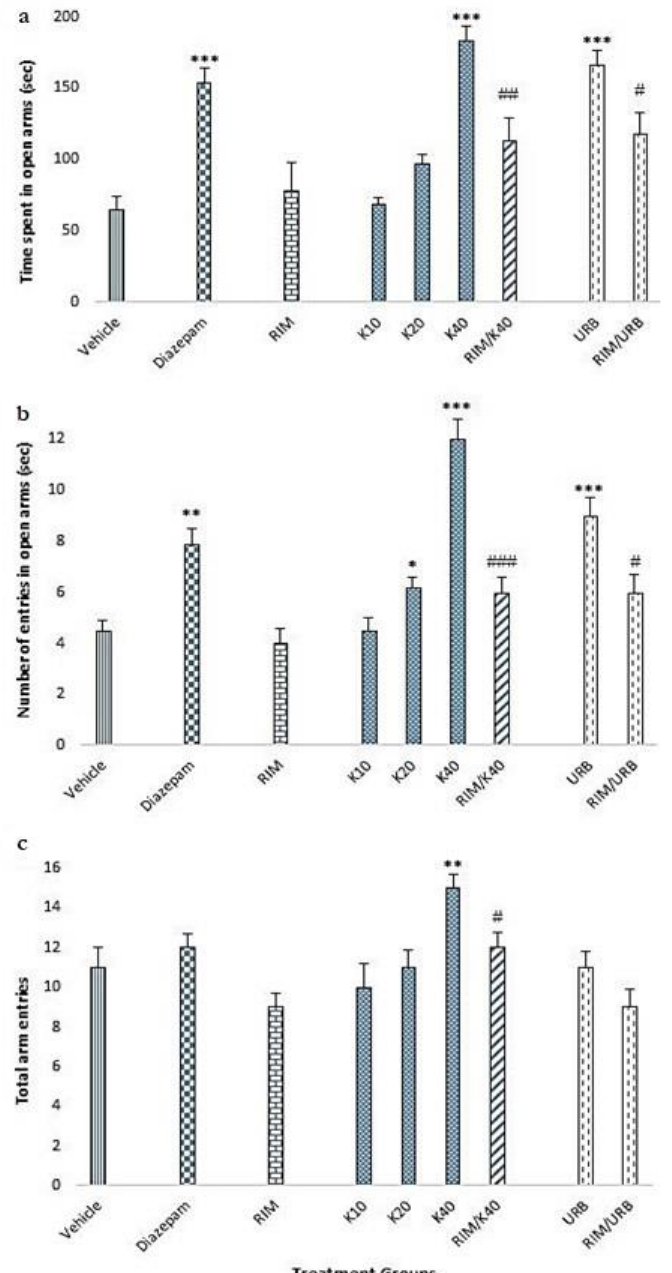
Figure 3. Effect of kaempferol on the levels of anxiety in elevated plus maze. After CFC, rats were subjected to EPM and parameters were noted: ( a ) Time spent in open arms. ( b ) Number of entries in the open arms. ( c ) Total arm eateries. Diazepam was used as standard. * p < 0.05, ** p < 0.01, and *** p < 0.001 as compared to vehicle control. # p < 0.05, ## p < 0.01, and ### p < 0.001 as compared to respective controls (URB or K40 alone), i.e., without CB1 antagonist RIM; 10, 20, 40 (kaempferol 10, 20, or 40 mg / kg), URB (URB597 1 mg / kg), RIM (rimonabant 1 mg /